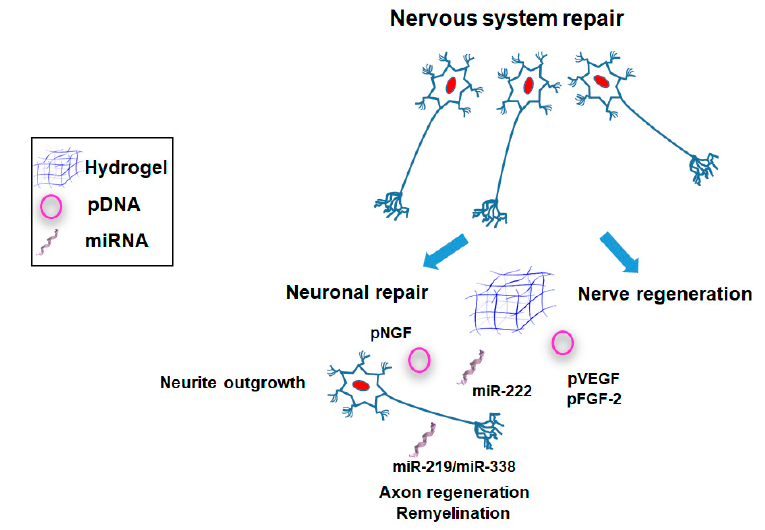
Figure 6. Main strategies involving the use of hydrogel-based gene delivery systems for nervous system repair.